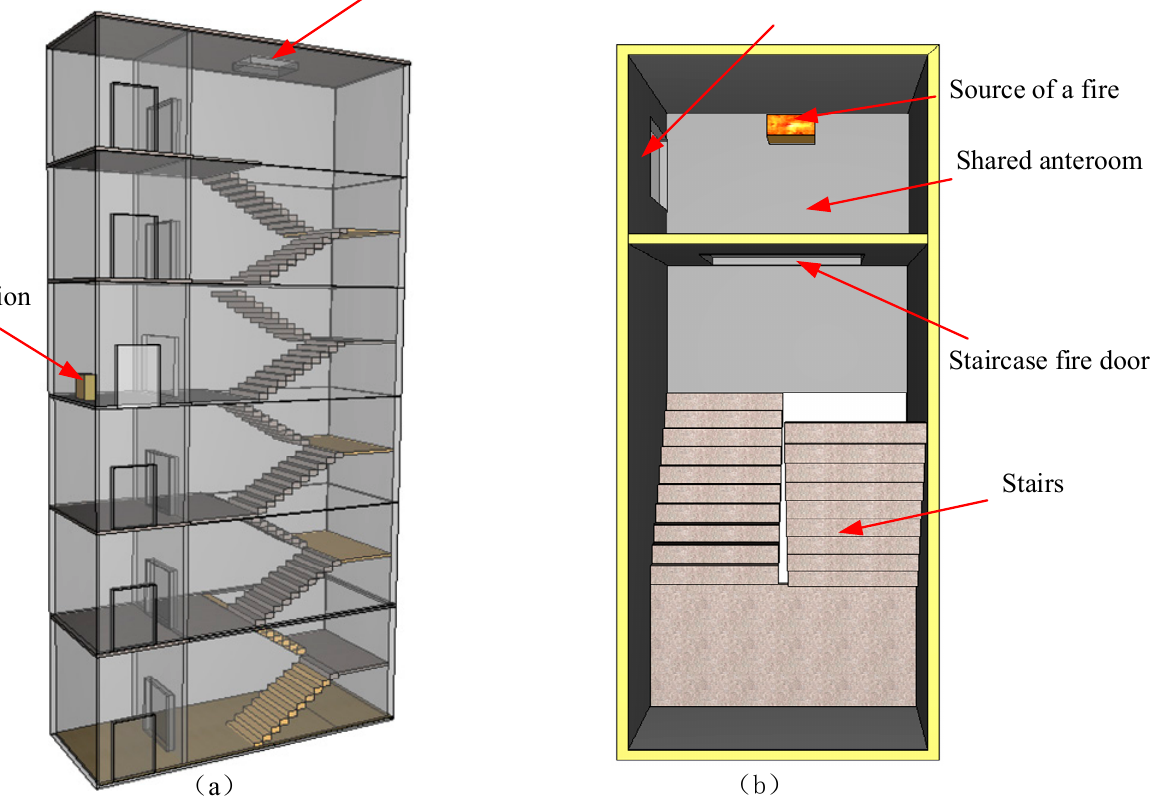
Figure 6. Fire simulation scenario. ( a ) Fire simulation object. ( b ) Staircase structure on the fourth floor.